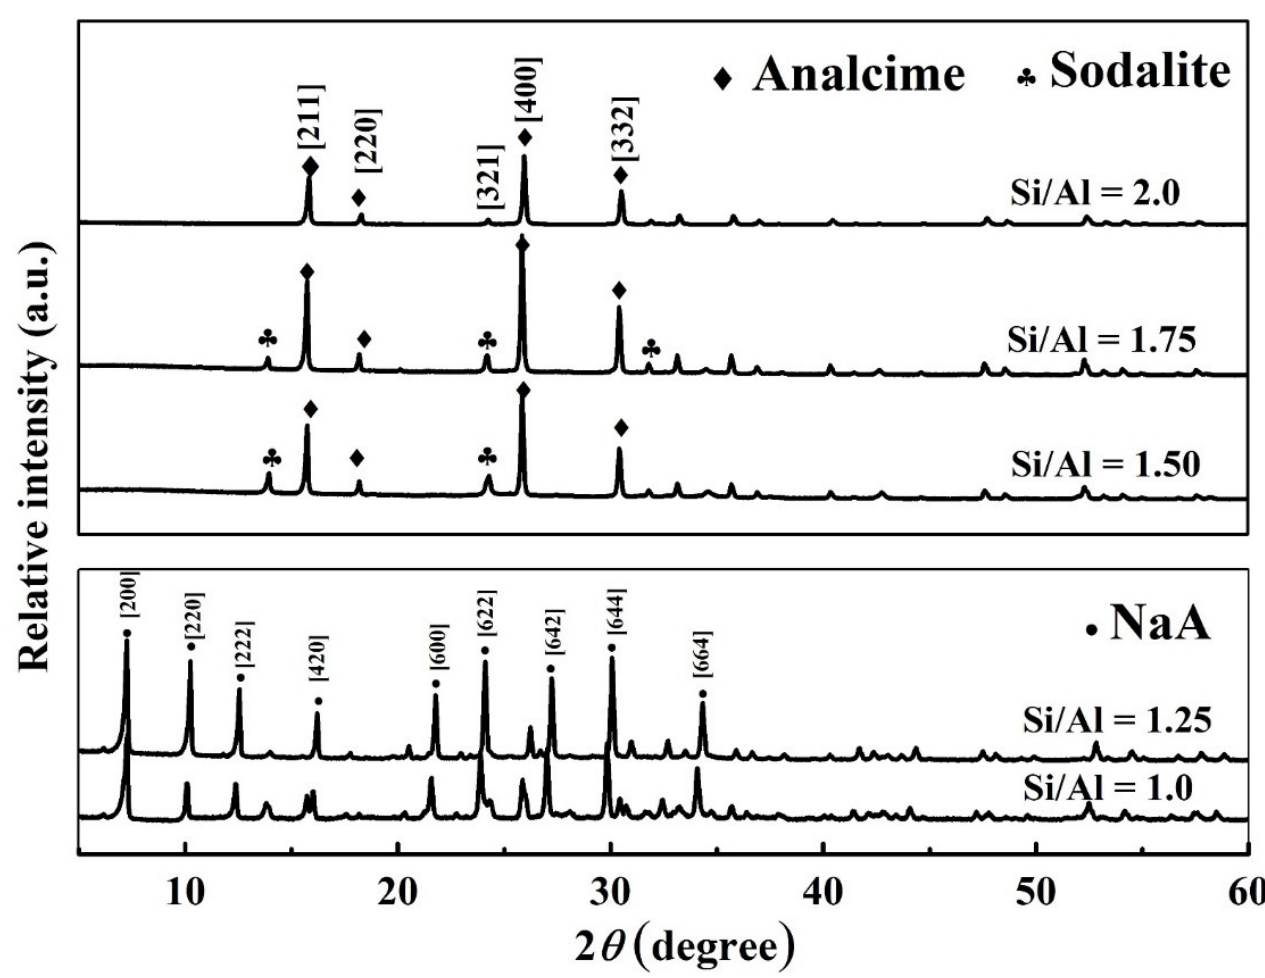
Figure 5. XRD patterns of specimens after hydrothermal treatment with various Si/Al molar ratios.